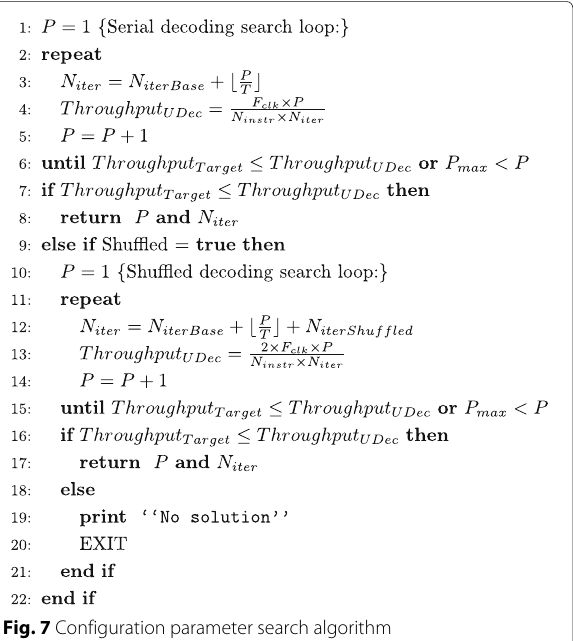
Fig. 7 Configuration parameter search